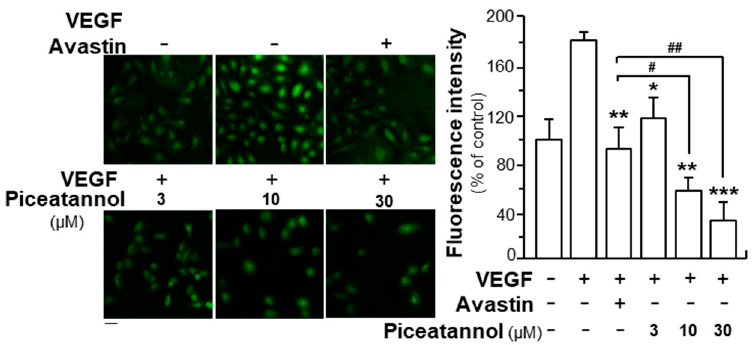
Figure 7. Piceatannol attenuates VEGF-triggered reactive oxygen species (ROS) formation. HUVECs with cell density set at 2 × 10 5 cells per well were seeded into each well of a 12-well plate. After 24 h, cells were treated with VEGF (10 ng/mL) in the presence or absence of piceatannol for 48 h. After the treatment, cells were incubated with DCFH-DA at 37 °C for 30 min and the level of intracellular ROS was further analyzed by laser confocal fluorescent microscopy. Avastin (200 µg/mL) served as a positive control. Data expressed as mean ± SEM of the percentage of change in comparison to control group, where n = 4; p < 0.05 (*); p < 0.01 (**); p < 0.001 (***) vs. VEGF-treated group. p < 0.05 (#); p < 0.01 (##) vs. Avastin-treated group, as shown. Bar = 40 µm.